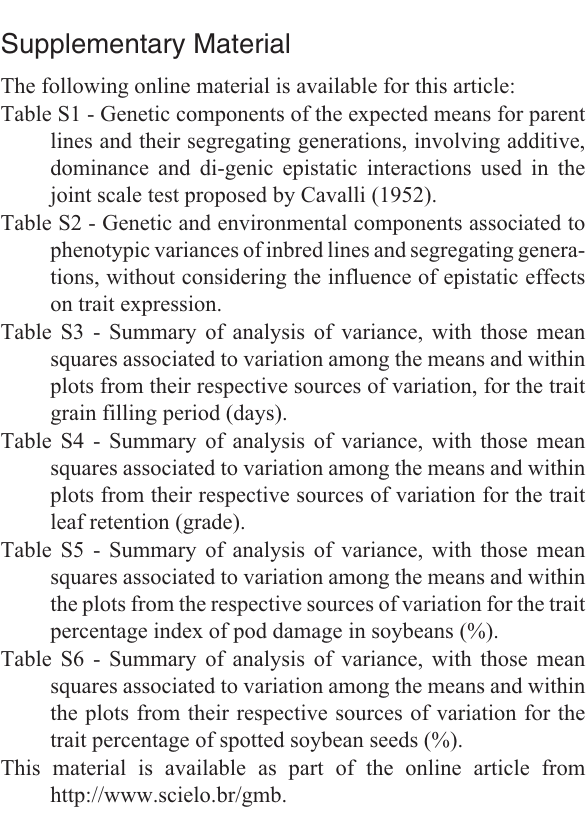
Table S1 - Genetic components of the expected means for parent lines and their segregating generations, involving additive, dominance and di-genic epistatic interactions used in the joint scale test proposed by Cavalli (1952). Table S2 - Genetic and environmental components associated to phenotypic variances of inbred lines and segregating genera- tions, without considering the influence of epistatic effects on trait expression. Table S3 - Summary of analysis of variance, with those mean squares associated to variation among the means and within plots from their respective sources of variation, for the trait grain filling period (days). Table S4 - Summary of analysis of variance, with those mean squares associated to variation among the means and within plots from their respective sources of variation for the trait leaf retention (grade). Table S5 - Summary of analysis of variance, with those mean squares associated to variation among the means and within the plots from the respective sources of variation for the trait percentage index of pod damage in soybeans (%). Table S6 - Summary of analysis of variance, with those mean squares associated to variation among the means and within the plots from their respective sources of variation for the trait percentage of spotted soybean seeds